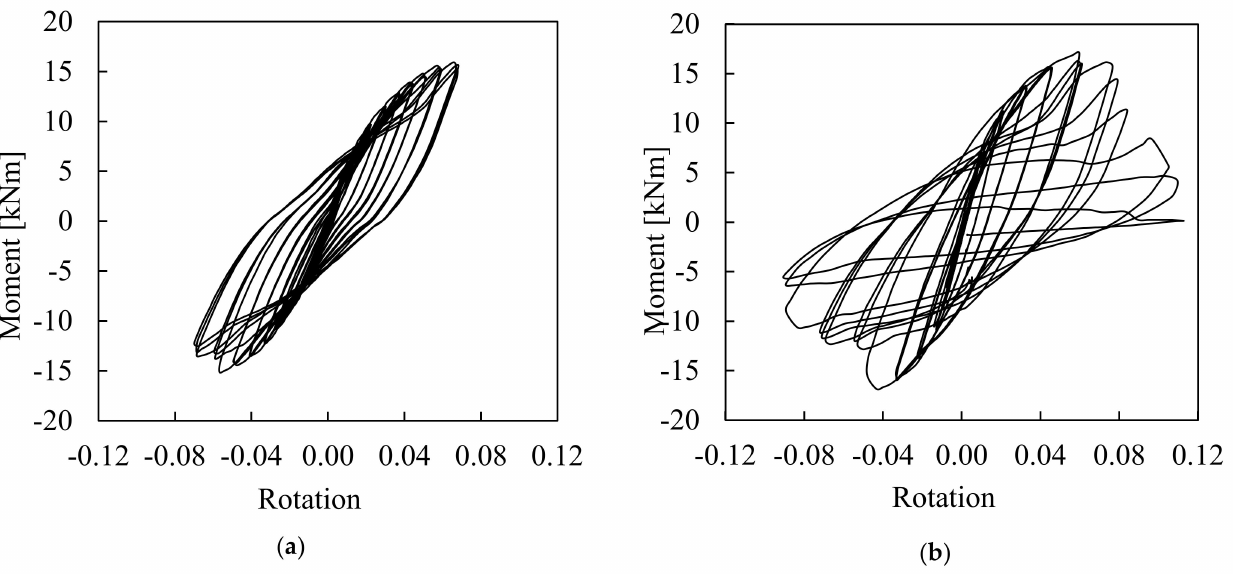
Figure 17. Moment versus rotation curves of the steel bolted joint specimens: ( a ) JL-4 specimen and ( b ) JL-6